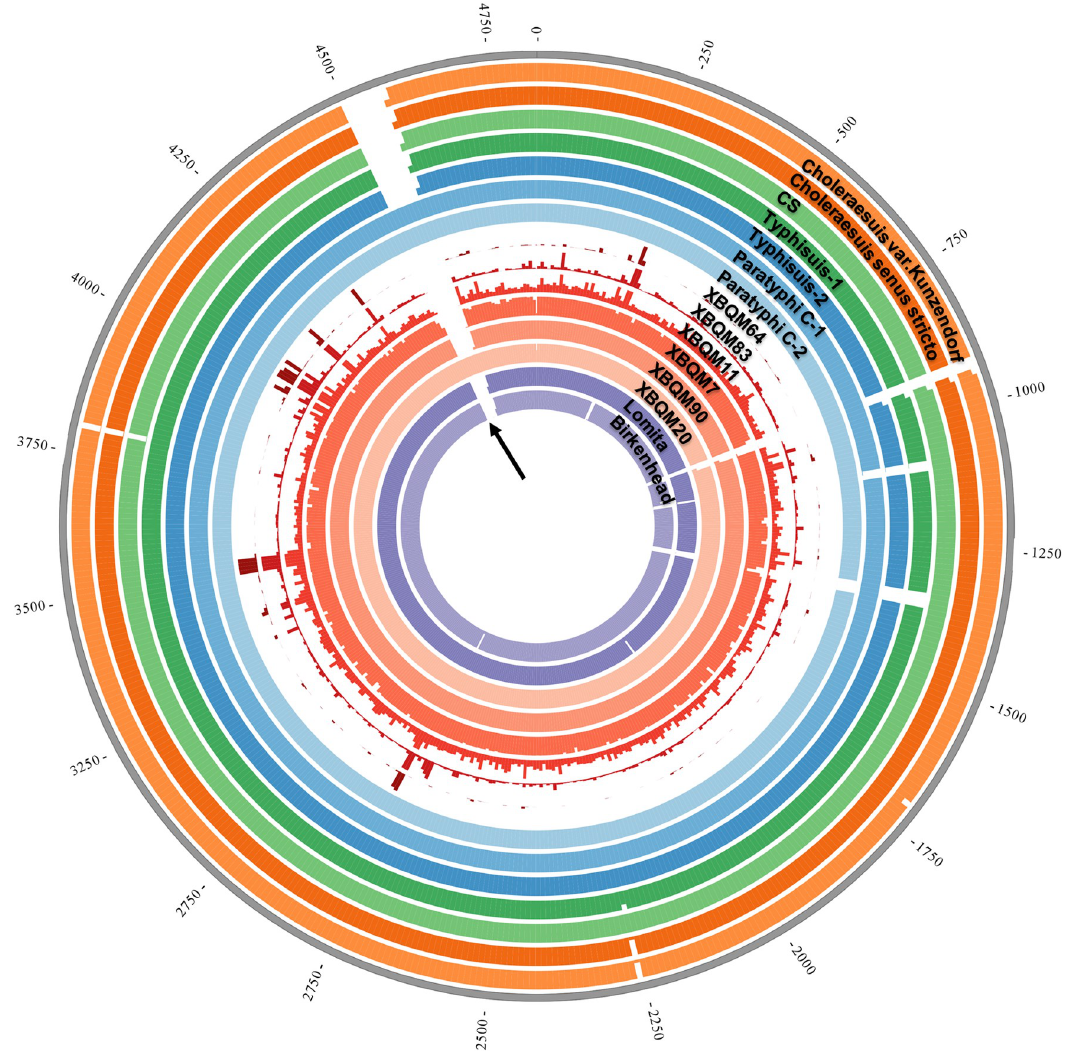
Fig 2. Coverage overview of the modern Para C and XBQ genomes. The average coverage was calculated for 10kb regions for the chromosome, each ring represents a maximum of 5X coverage. The figure was generated with Circos [80]. The black arrow represents the position of